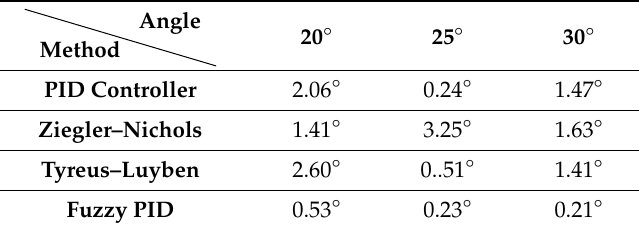
Table 10. Steady-state error in Experiment